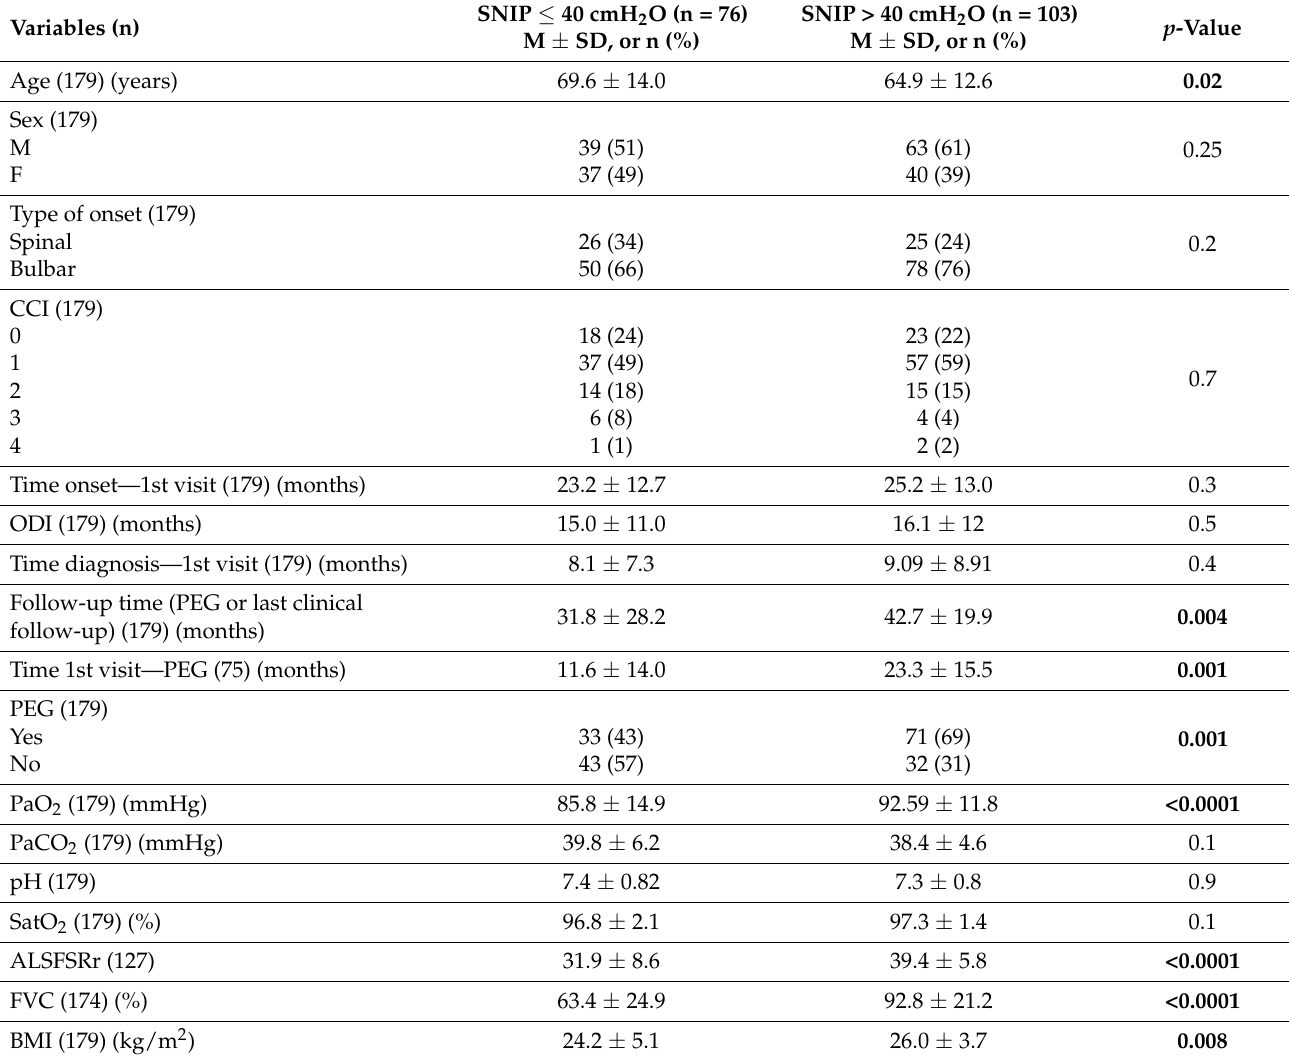
CCI: Charlson comorbidity index. ODI: onset-diagnosis interval. PEG: percutaneous endoscopic gastrostomy. ALSFRSr: amyotrophic lateral sclerosis functional rating scale revised. SNIP: sniff nasal inspiratory pressure. FVC: forced vital capacity. BMI: body mass index.